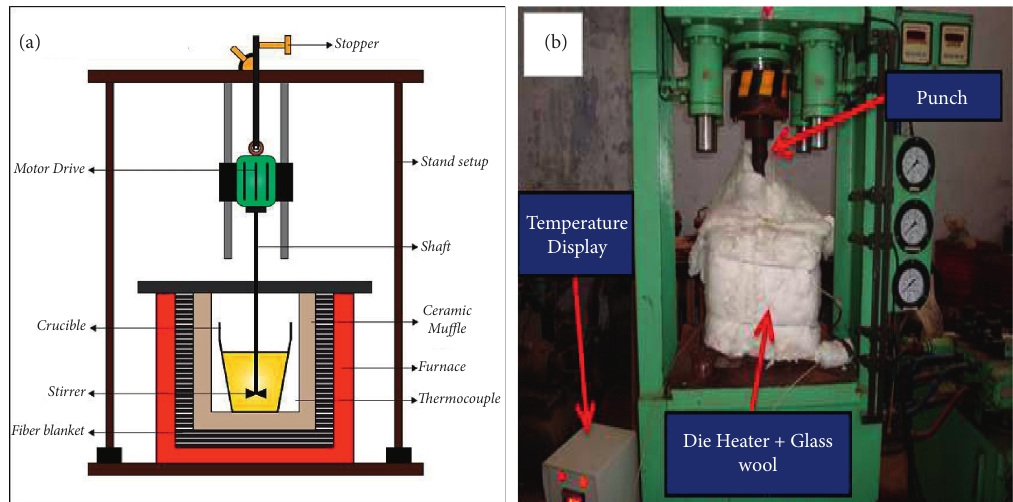
Figure 3: (a) Melt stirring setup. (b) Die and punch preheating for the preparation of composite.